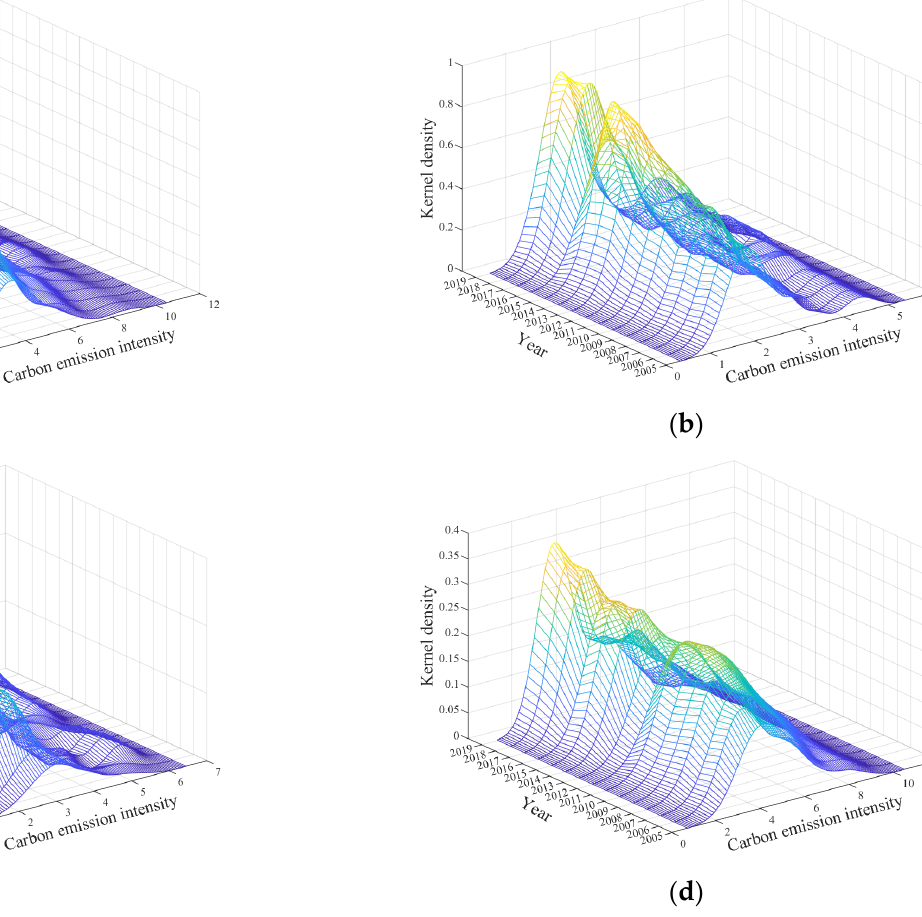
Figure 6. Kernel density estimation of national and regional carbon emission intensity from 2005 to 2019. ( a ) National. ( b ) Eastern region. ( c ) Central region. ( d ) Western region.